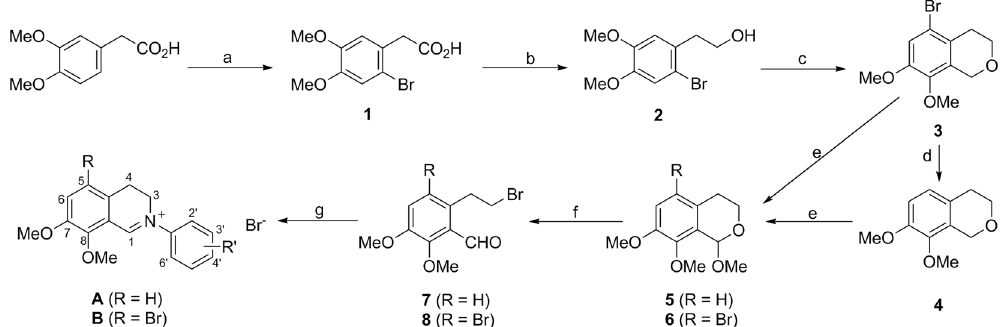
Figure 2. Synthetic route of compounds A and B . Reagents and conditions: ( a ) dry Br 2 , dry CH 2 Cl 2 ; ( b ) NaBH 4 , I 2 , dry THF, 0 to 40 °C; ( c ) (HCHO) n , TFA, r.t.; ( d ) n-BuLi, dry THF, − 78 °C; ( e ) DDQ, dry MeOH, dry CH 2 Cl 2 ; ( f ) TMSBr,